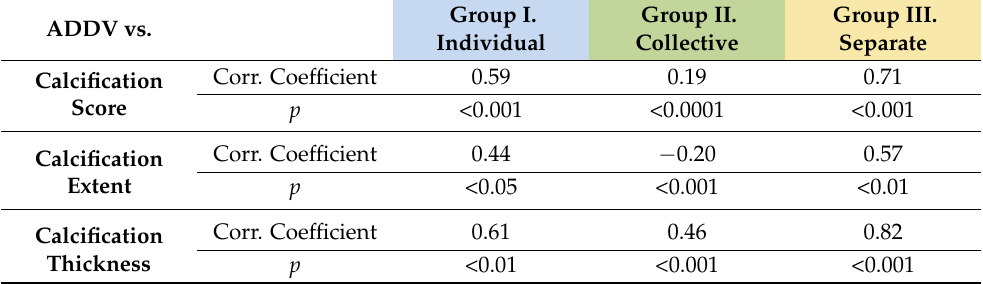
Table 4. Pearson correlation coefficients and p values calculated between ADDV (average diameter difference normalized by the voxel length) and calcification metrics in each